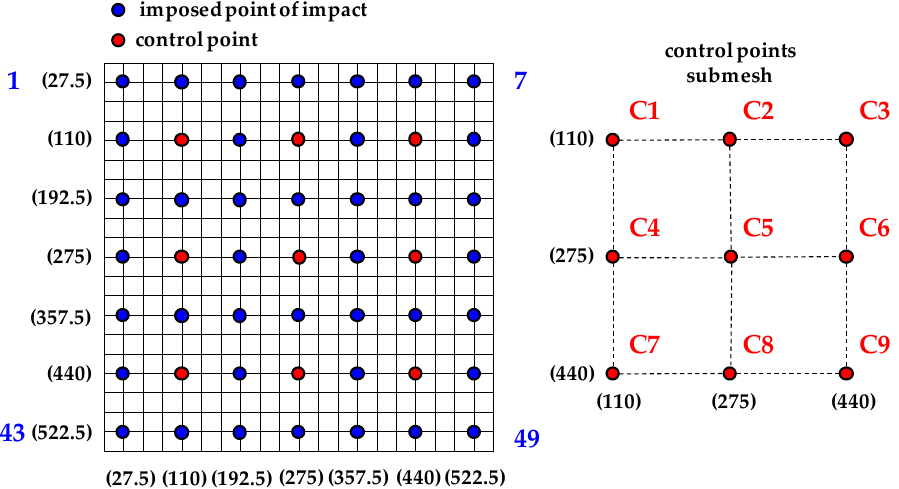
Figure 3. Matrices for the construction of the ANN: 49 impact and 9 detection points (numbers in brackets are in millimeters).